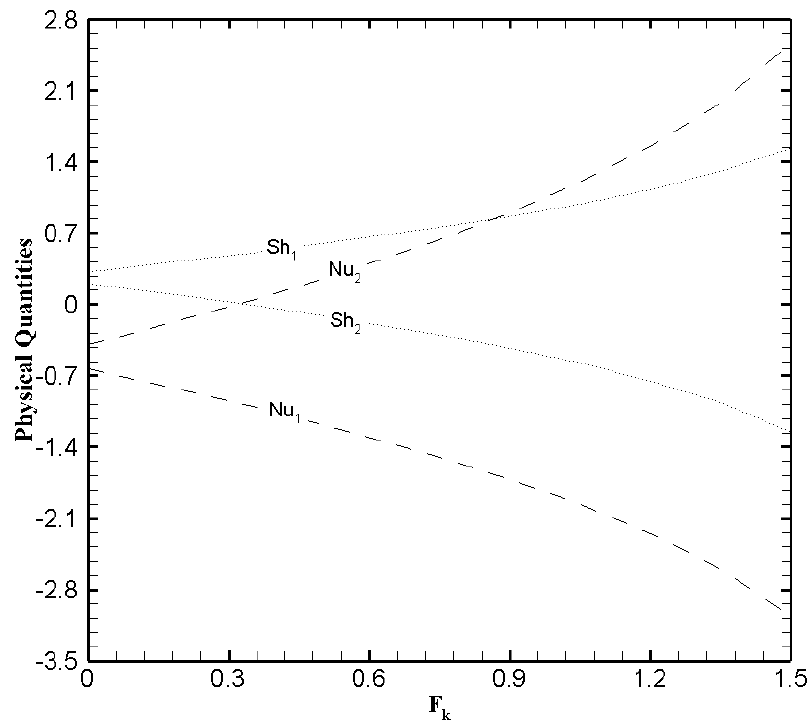
Figure 15. The physical quantities with F k when ζ = P = κ = Ha = Br = δ θ 2 = 1, N b = 0.2, N t = 0.1, β = 0.05 and δ θ 1 =